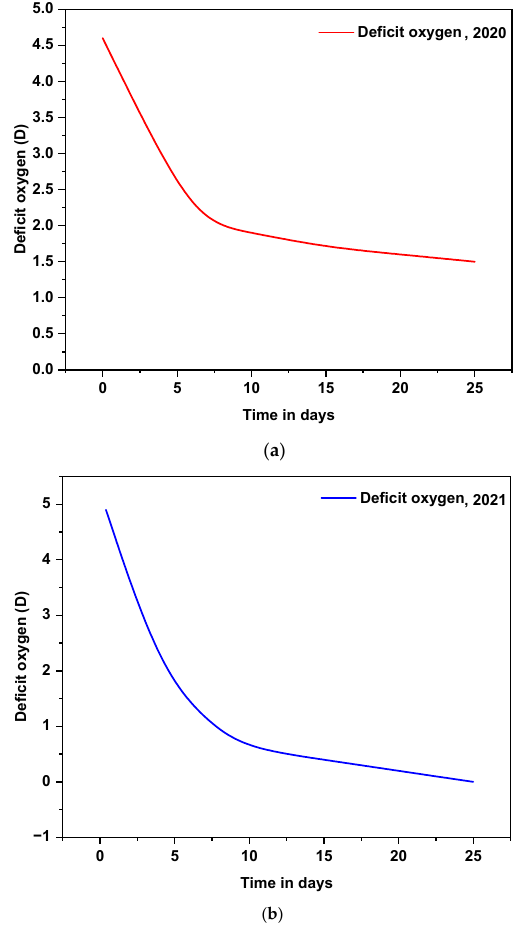
Figure 6. ( a ) Oxygen deficit (D) as a function of time (day) for the year 2020. ( b ) Variation of oxy- gen deficit with time for the data of 2021 (simulation conducted as per the modeling contemplated for